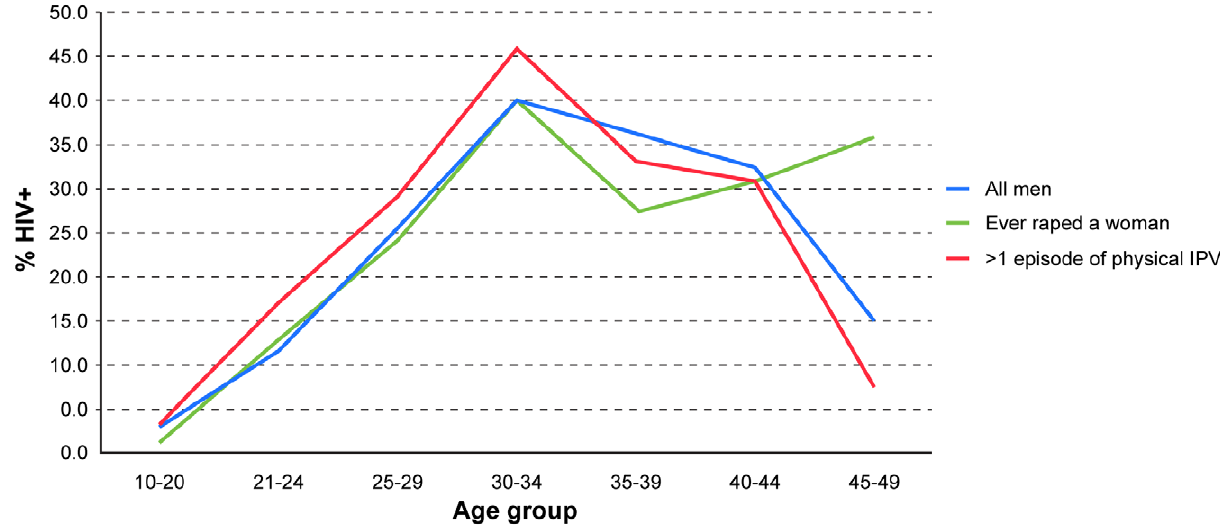
Figure 1. Age-specific HIV prevalence by perpetration of rape or physical intimate partner violence.